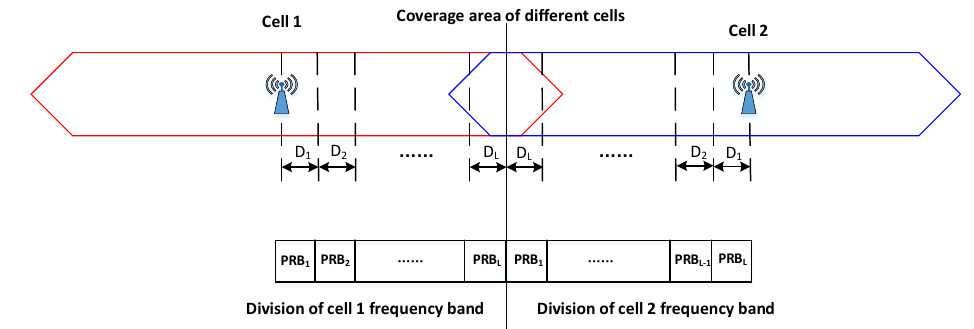
Figure 2. Frequency band in different coverage areas in the